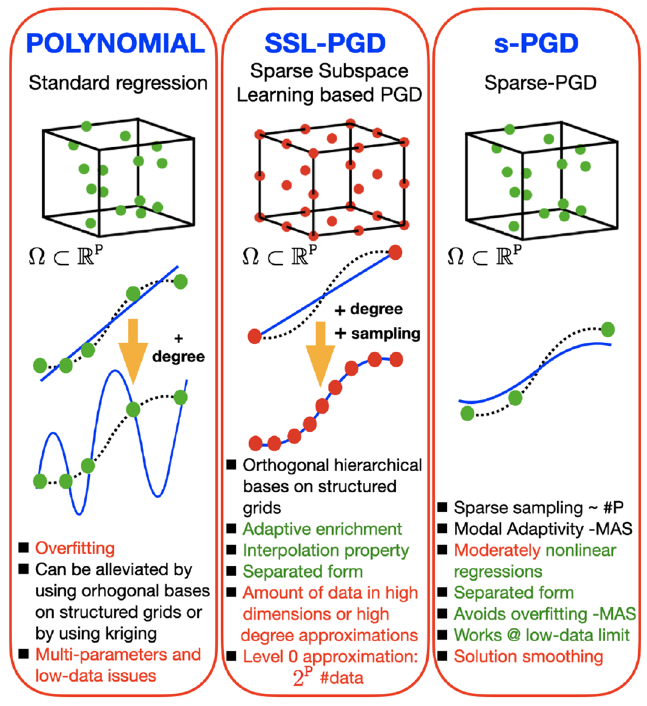
Fig. 1 Part A. Non-intrusive MOR techniques with the main sampling and approximation features, their pros (emphasized in the green text) and the cons (in red)